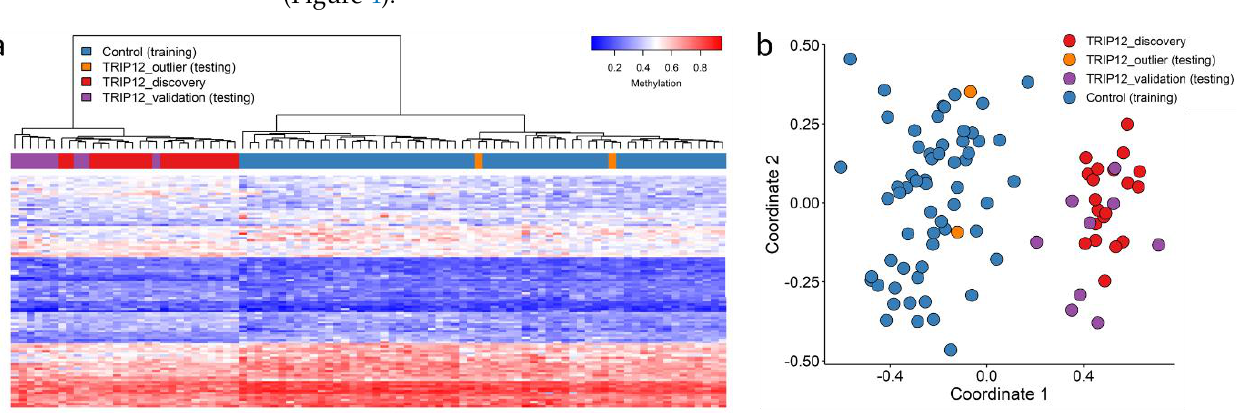
Figure 3. Clark – Baraitser syndrome (TRIP12) episignature — discovery cohort: ( a ) Euclidean hierar- chical clustering (heatmap): each column represents a single TRIP12 discovery case or control; each row represents 1 of the 105 CpG probes selected for the episignature. This heatmap shows clear separation between 20 TRIP12 cases (red) from controls (blue). Two outlier cases (orange) are shown to segregate with controls; ( b ) Multidimensional scaling (MDS) plot shows segregation of TRIP12 cases from both controls and outlier cases; ( c ) Support Vector Machine (SVM) classifier model. The model was trained using the 105 selected TRIP12 episignature probes, 75% of controls and 75% of other neurodevelopmental disorder samples (blue). The remaining 25% controls and 25% of other disorder samples were used for testing (grey). Plot shows the TRIP12 discovery cases with a meth- ylation variant pathogenicity (MVP) score close to 1 compared with all other samples, showing the specificity of the classifier and episignature.